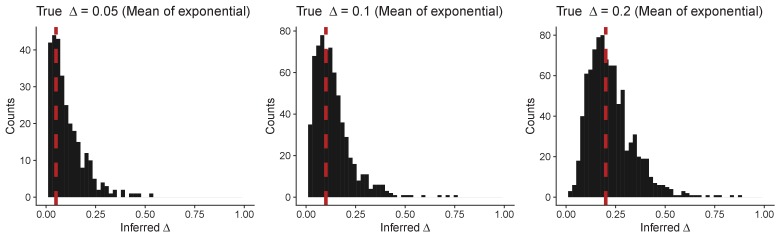
Histogram of inferred Δ values from simulations using an exponentially distributed fitness effect.For each panel the mean of the exponential distribution used for Δ is stated above and illustrated by the red dashed lines.